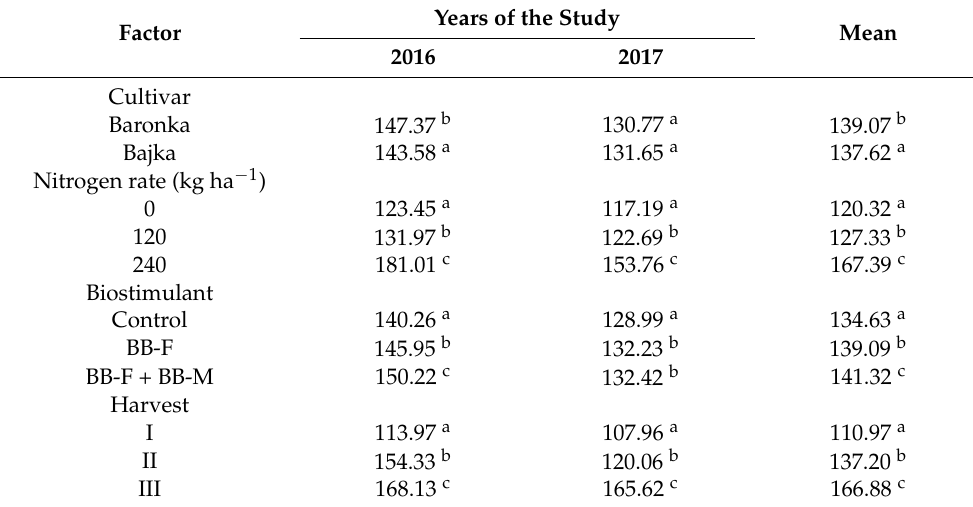
Table 2. Content of crude protein in perennial ryegrass biomass (g kg − 1